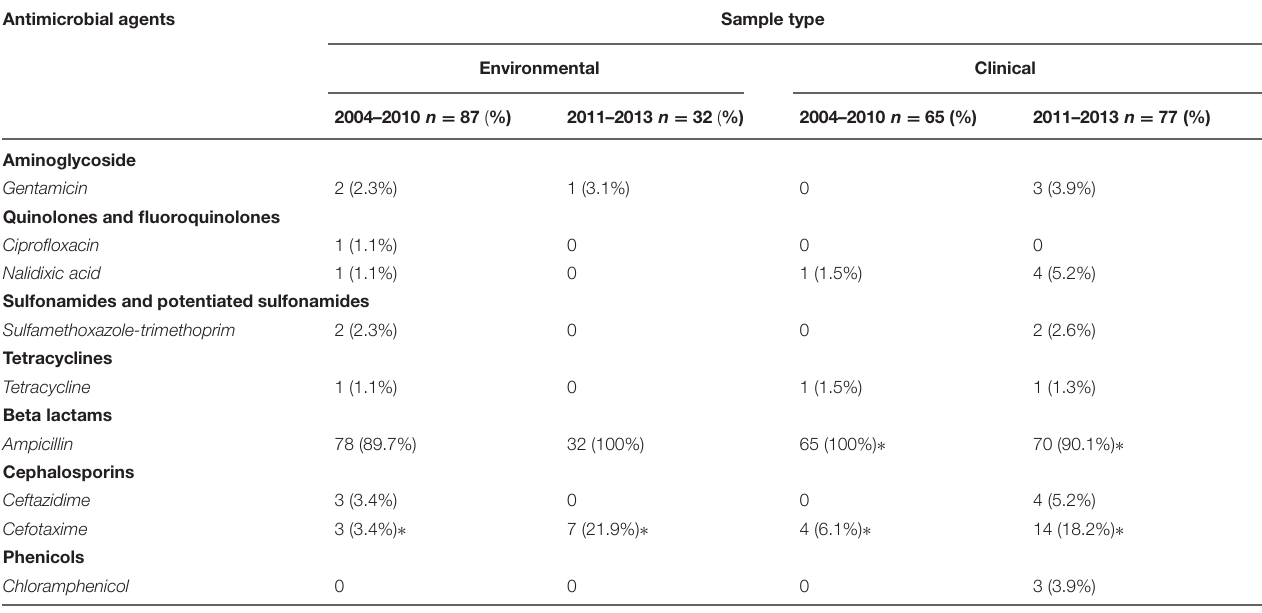
TABLE 2 | Distribution of antibiotic resistance among clinical and environmental Vibrio parahaemolyticus strains isolated from 2004–2010 and 2011–2013 periods. Antimicrobial agents